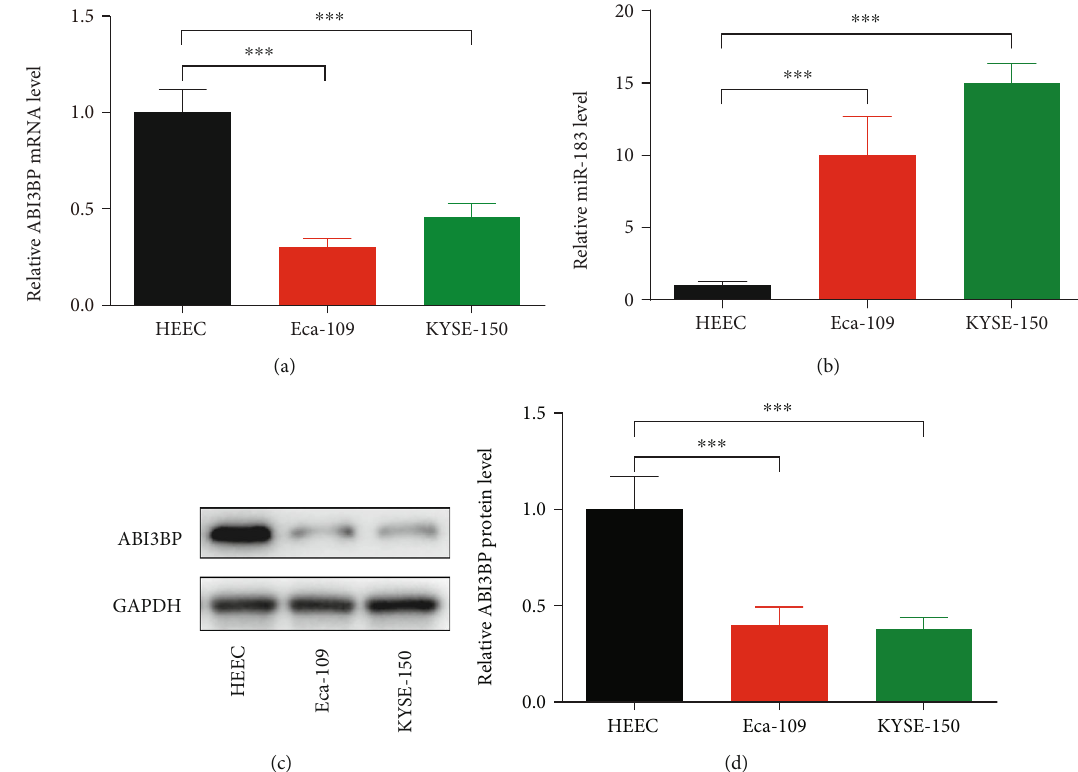
Figure 3: The expression levels of ABI3BP and miR-183 in HEEC, Eca-109, and KYSE-150 cells. Three kinds of cells were cultured and harvested when growing to 80-90%. Total mRNA or protein was extracted and detected by real-time PCR or Western blot analysis. (a) Relative ABI3BP mRNA level was detected by using RT-PCR. Five independent experiments ( n = 5 ) were repeated for each cell line. (b) Relative miR-183-3p level was detected by using RT-PCR. Five independent experiments ( n = 5 ) were repeated for each cell line. (c) Relative ABI3BP protein level was detected by Western blot. Five independent experiments ( n = 5 ) were repeated for each cell line. (d) Quantitative analysis of (c). ∗∗∗ P < 0 : 001 , one-way ANOVA with post